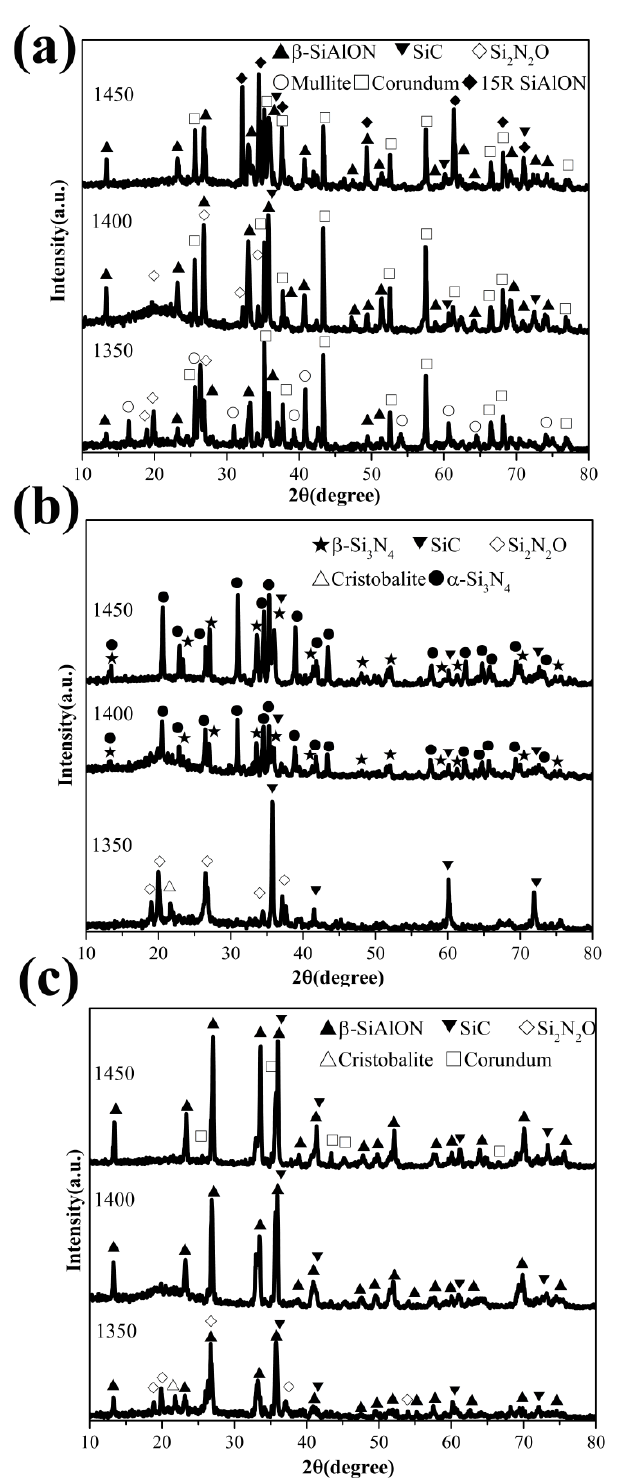
Figure 2. XRD patterns of the products obtained from different starting materials: ( a ) pulverized coal furnace fly ash ( b ) diatomite ( c ) raw illite. During CRN calcination, these raw materials are partly reduced and nitrified. The XRD patterns of the products obtained from different starting materials are shown in Figure 2. The phase